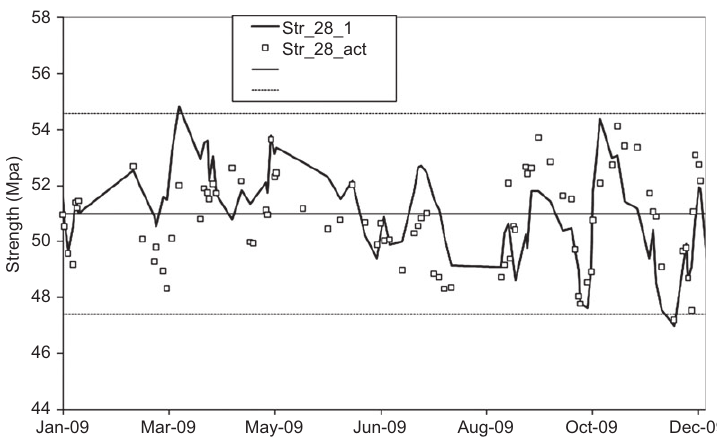
Figure 12 SM application for CEM AL 42.5 N.